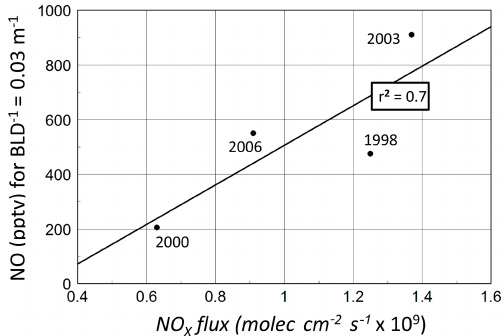
Figure 12. NO (BLD = 33 . 3m) vs. seasonally averaged NO x flux from Table 2 using a fall-off factor of 5 (typical of shallow boundary